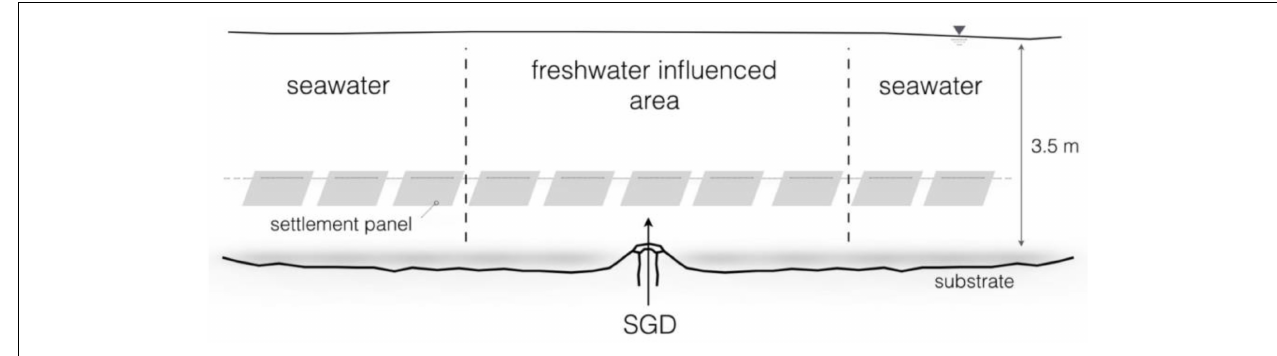
FIGURE 2 | Experimental design of the 10-day in situ biofouling experiment in 3.5 m water depth. In total 26 settlement panels were used, five panels exposed to the submarine spring and twenty-one to seawater.